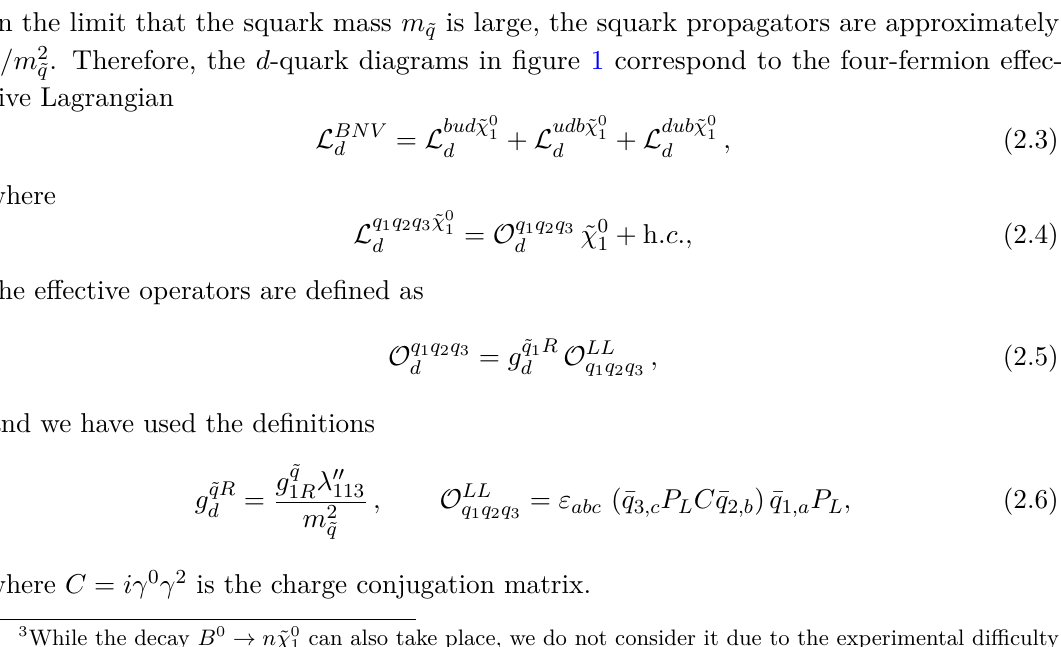
, where B stands for one of the baryons 1 ); Λ , Σ + , Σ 0 (for λ 00 113